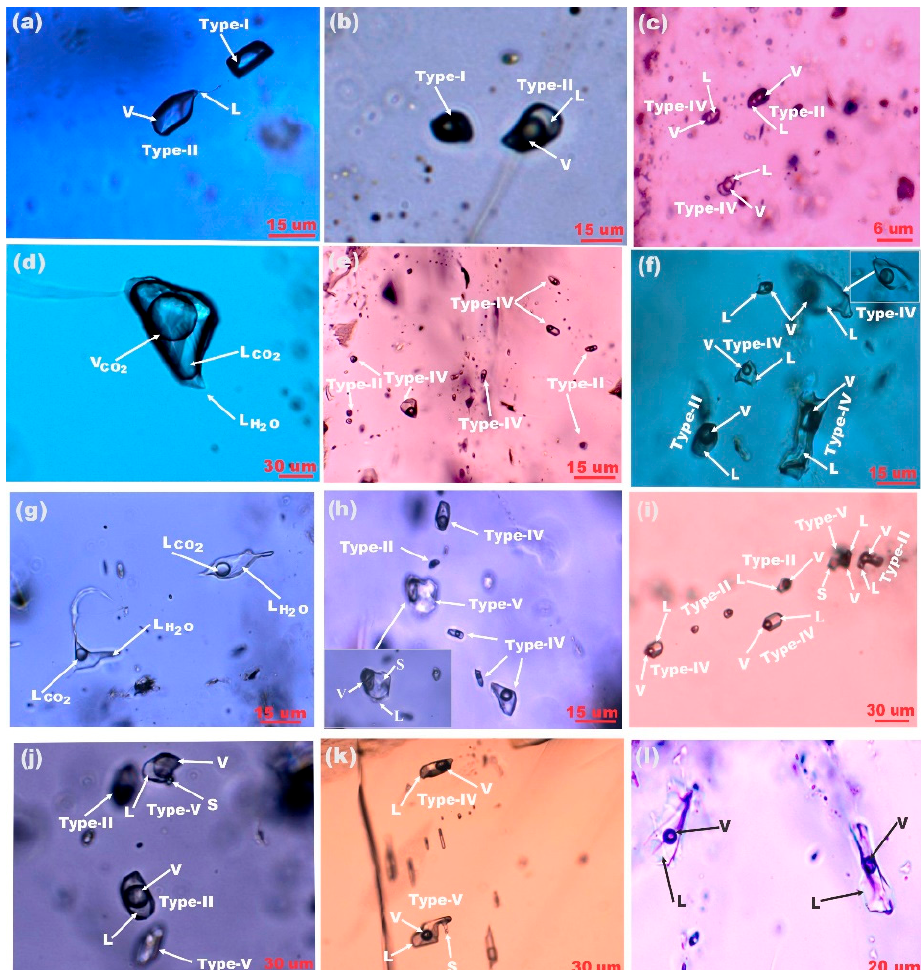
Figure 7. Photographs of fluid inclusion from the Cu-Pb polymetallic mineralization, Kargah: ( a ) Type I and type II inclusions in the pre-ore stage quartz grains; ( b ) sulfide stage I shows the type I and type II inclusions in chalcopyrite bearing quartz vein; ( c ) the coexistence of type II and type IV inclusions in quartz grains of the pre-ore stage; ( d ) type IIIb (aqueous-carbonic) inclusion in the pre-ore stage quartz grain; ( e ) assemblages of type II and type IV inclusions in the sulfide stage I quartz grain; ( f ) sulfide stage I shows type IV inclusions with type II inclusions in quartz grains; ( g ) two-phase type IIIa (aqueous-carbonic) inclusions at room temperature in quartz grain of sulfide ore stage I; ( h ) the coexistence of type V (solid inclusion) with type IV and type II inclusions in sulfide ore stage II; ( i ) sulfide stage II shows coexistence of type II, type IV, and type V inclusions in zincian-tetrahedrite rich quartz vein; ( j ) type II inclusions associated with type V (solid inclusion) in the sulfide stage II of quartz vein; ( k ) type IV and type V inclusions in sulfide stage II quartz bearing vein; ( l ) post-ore stage shows the type IV inclusions in calcite vein. L, liquid; V, vapor; LH 2 O, liquid H 2 O; LCO 2 , liquid CO 2 ; VCO 2 , vapor CO 2 ; S, halite crystal.